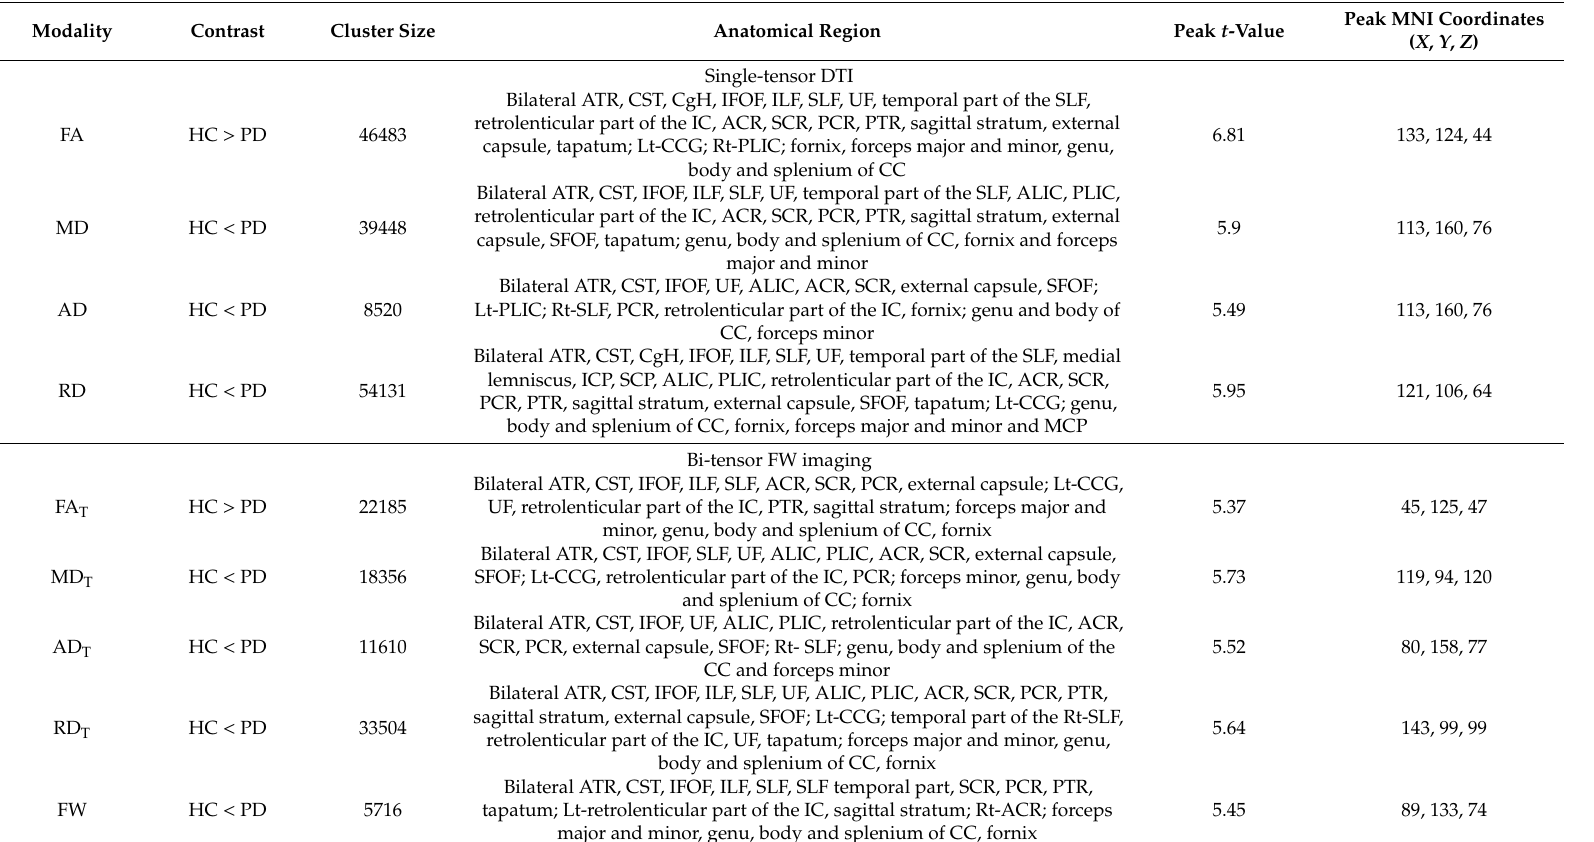
Table 2. Tract-based spatial statistics analysis of di ff usion tensor and free-water imaging indices in patients with Parkinson’s disease and healthy